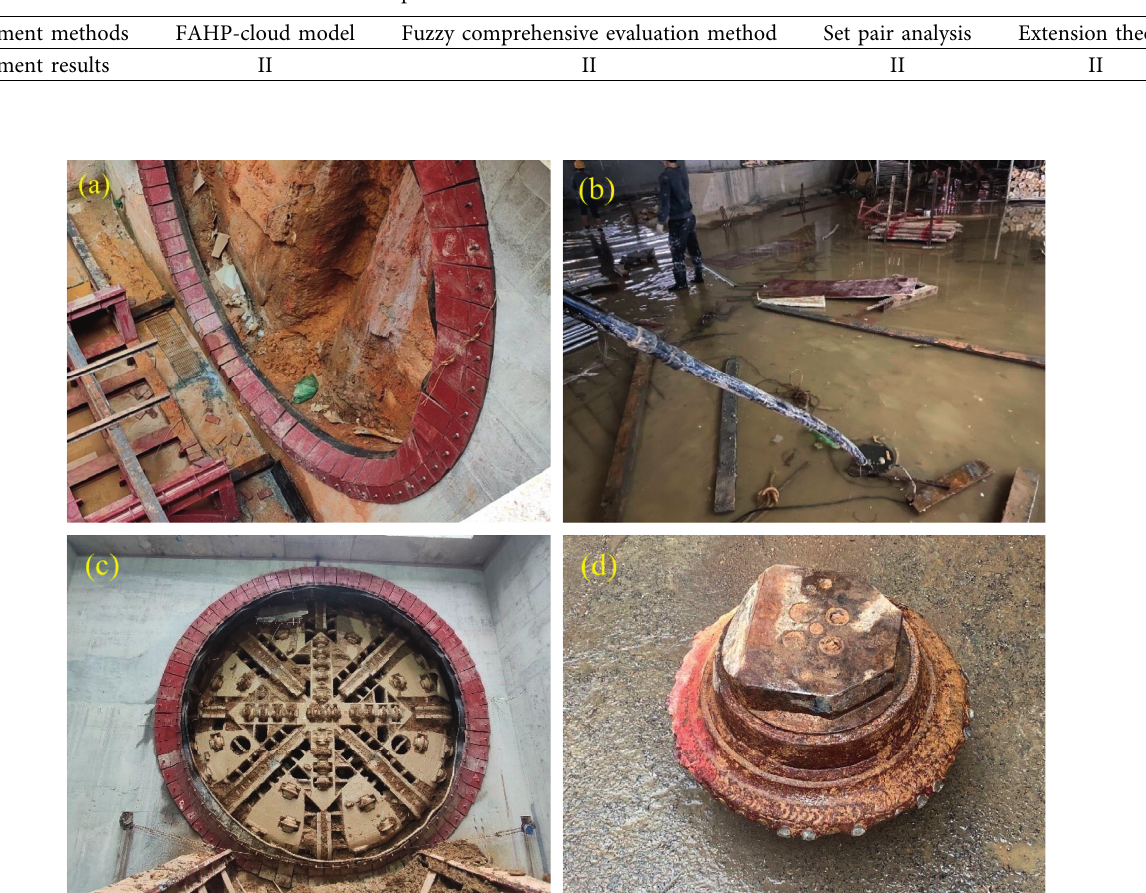
Table 10: Result comparison of the FAHP-cloud model with other methods.